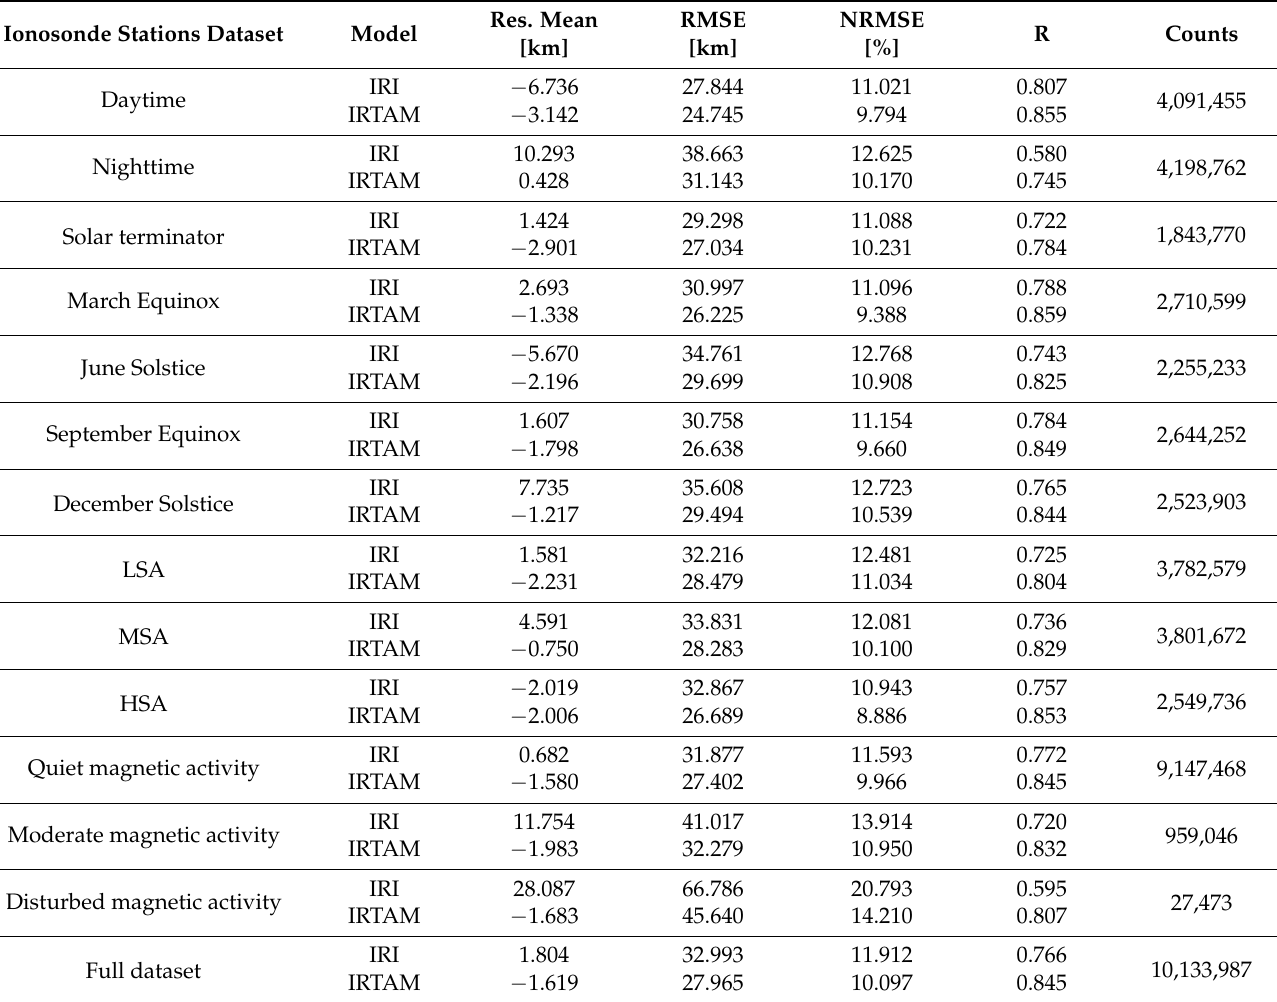
Table 5. Res. Mean, RMSE , NRMSE , and R values calculated for the IRI and IRTAM models on the basis of the hm F2 ground-based ionosondes observations, for the bins defined in Section 4.2, according to the three levels of solar activity defined in Section 3.1, and for the full dataset (bottom row). The number of counts on which the statistics were calculated is reported in the rightmost